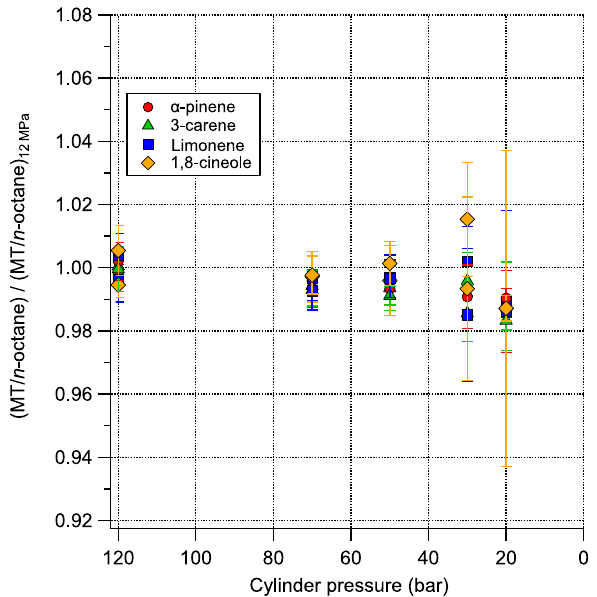
Figure 2. The relative difference between the amount fraction of the decanted mixtures and the expected amount fraction based on gravi- metric value of the mixture before any decanting. Each decantation was performed twice for each passivation type.